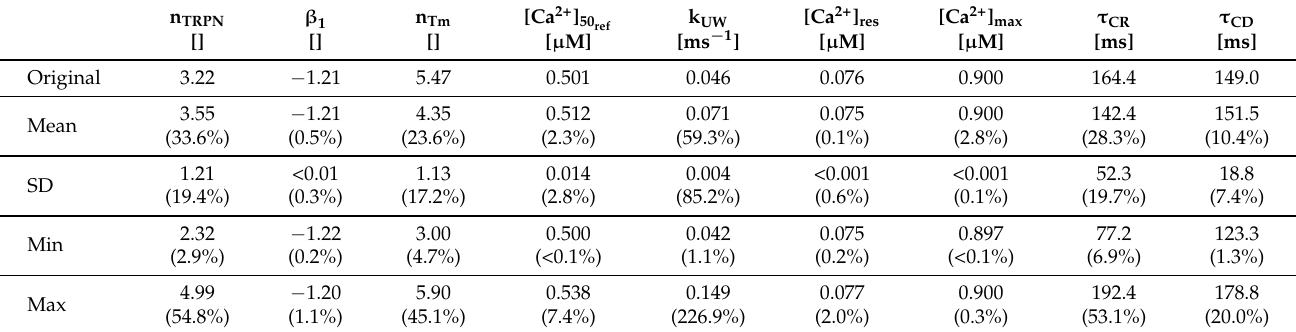
Table 9. Results of the initial guess variation robustness analysis for the patient case 02-CoA. Esti- mated model parameters of the second step of the active mechanics personalisation approach are given. The original values produced by the default initial guesses are listed in the first row and means (M), standard deviations (SD), minima (Min), and maxima (Max) of five samples are listed in the subsequent rows. Means, standard deviations, minima, and maxima of the relative differences are given in brackets below.